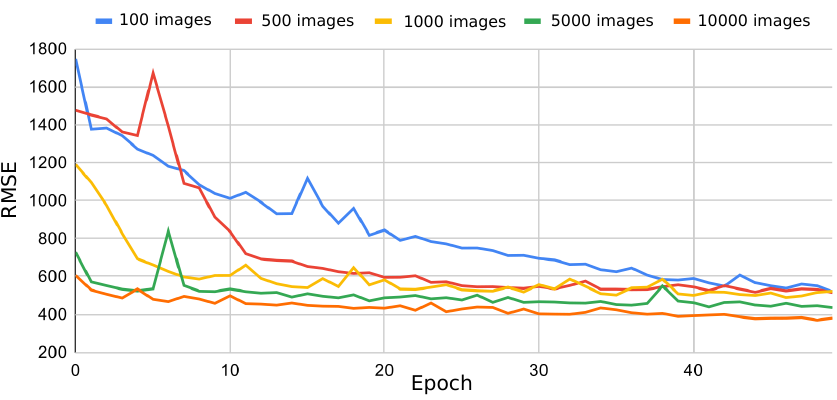
Figure 8. Validation error during training for a ResNet with different dataset